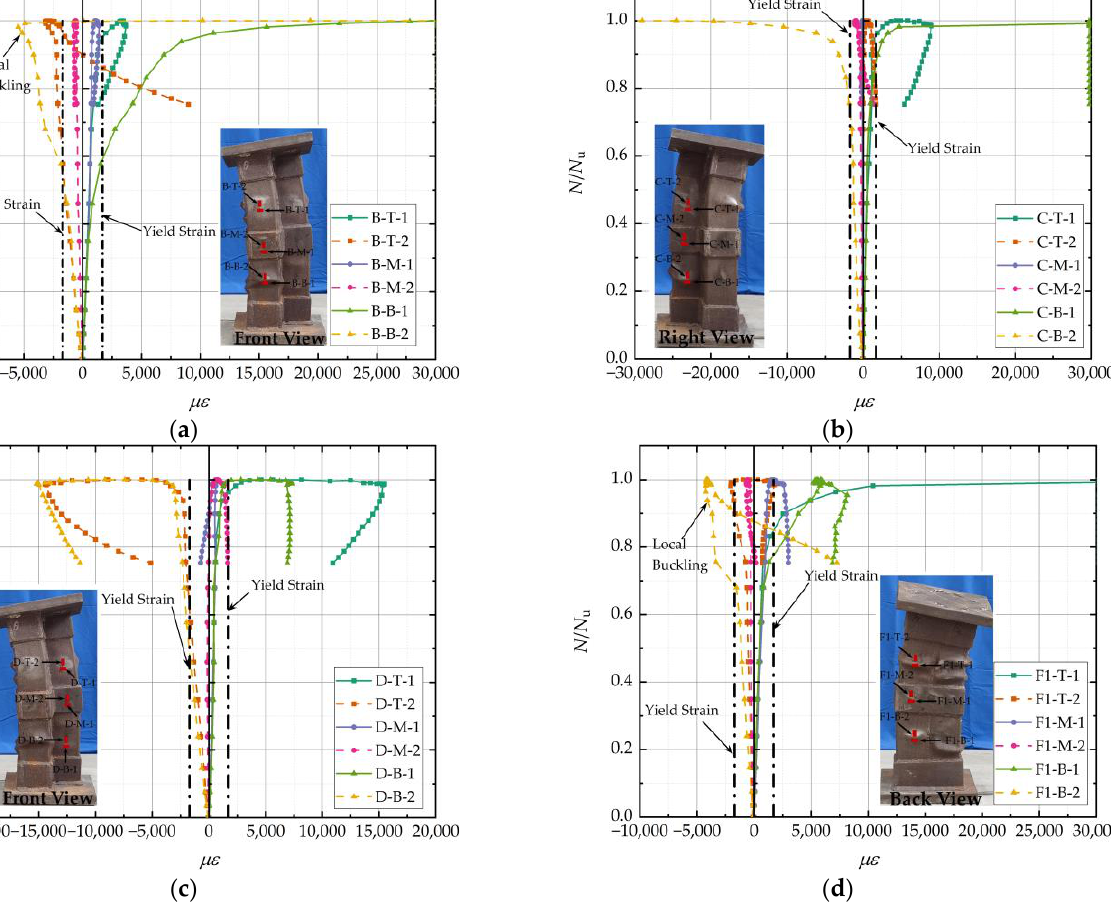
Figure 13. Load – strain curves of the HL-1 specimen ( a ) Surface B; ( b ) Surface C; ( c ) Surface D; ( d ) Surface F1.